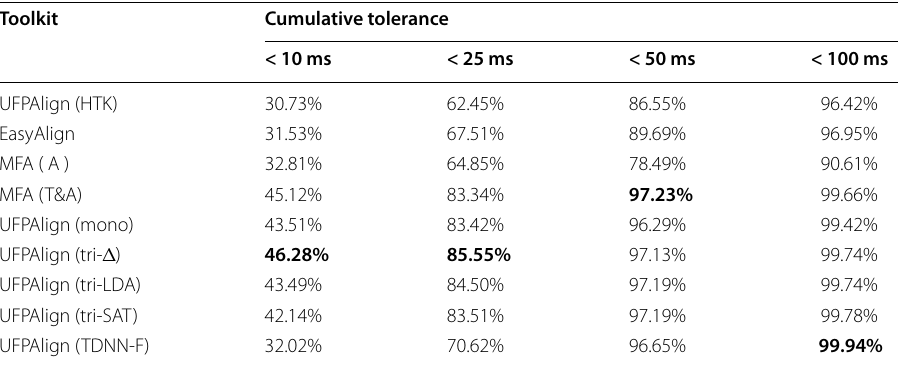
Table 11 Results for the male dataset regarding the cumulative percentage below a tolerance threshold, in milliseconds, of the differences between forced aligned audio and ground-truth phonemes, also known as phone